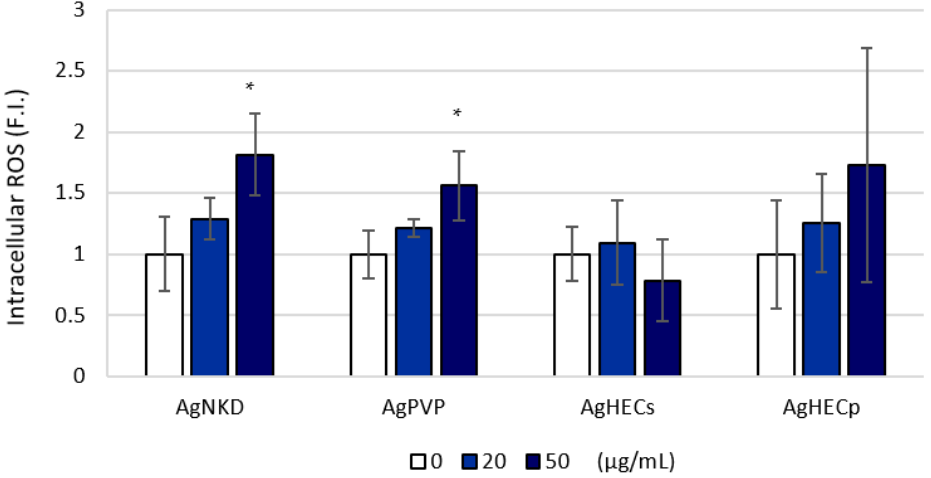
Figure 5. Reactive oxygen species were significantly increased after 90 min of treatment in AgNKD and AgPVP exposed cells (50 µg/mL). Data are presented as the mean of at least three independent experiments ± standard deviation. Statistical analysis: one-way ANOVA followed by Dunnett’s test. * p < 0.05 compared to control non exposed cells.